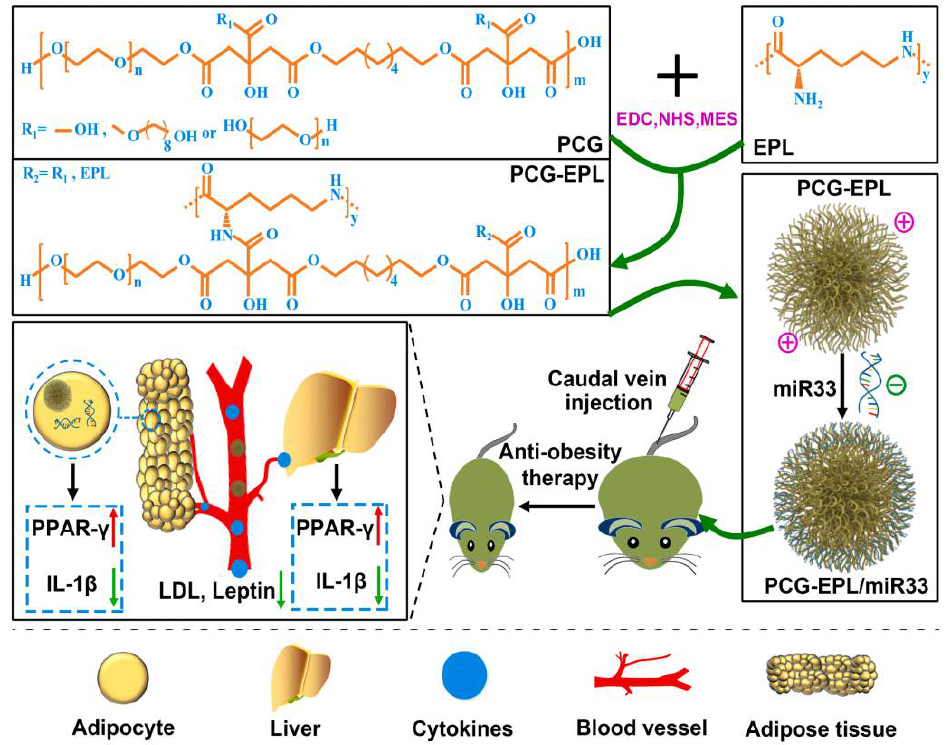
Figure 5. Schematic depiction for the synthesis of PCG-EPL/miRNA and the application of PCG- EPL/miR33 agonist in obesity therapy. Reproduced with permission [158]. Copyright 2021, Elsevier.